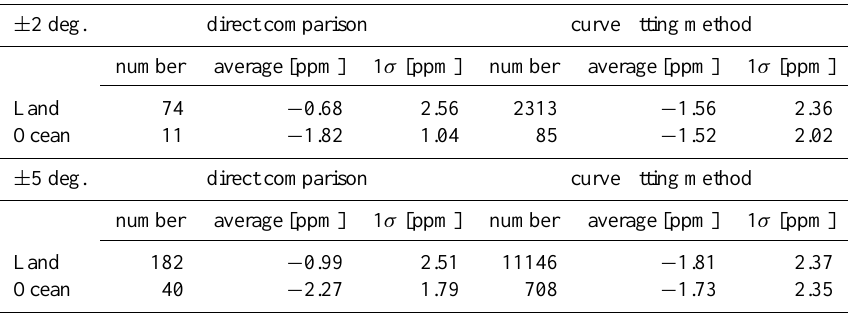
Table 5. The average and 1 standard deviation (1 σ ) of the differences between GOSAT XCO 2 and aircraft-based XCO 2 for all sites by direct comparison and the curve fitting method. ± 2 deg. direct comparison curve fitting method number average [ppm] 1 σ [ppm] number average [ppm] 1 σ [ppm] Land 74 − 0.68 2.56 2313 − 1.56 2.36 Ocean 11 − 1.82 1.04 85 − 1.52 2.02 ± 5 deg. direct comparison curve fitting method number average [ppm] 1 σ [ppm] number average [ppm] 1 σ [ppm] Land 182 − 0.99